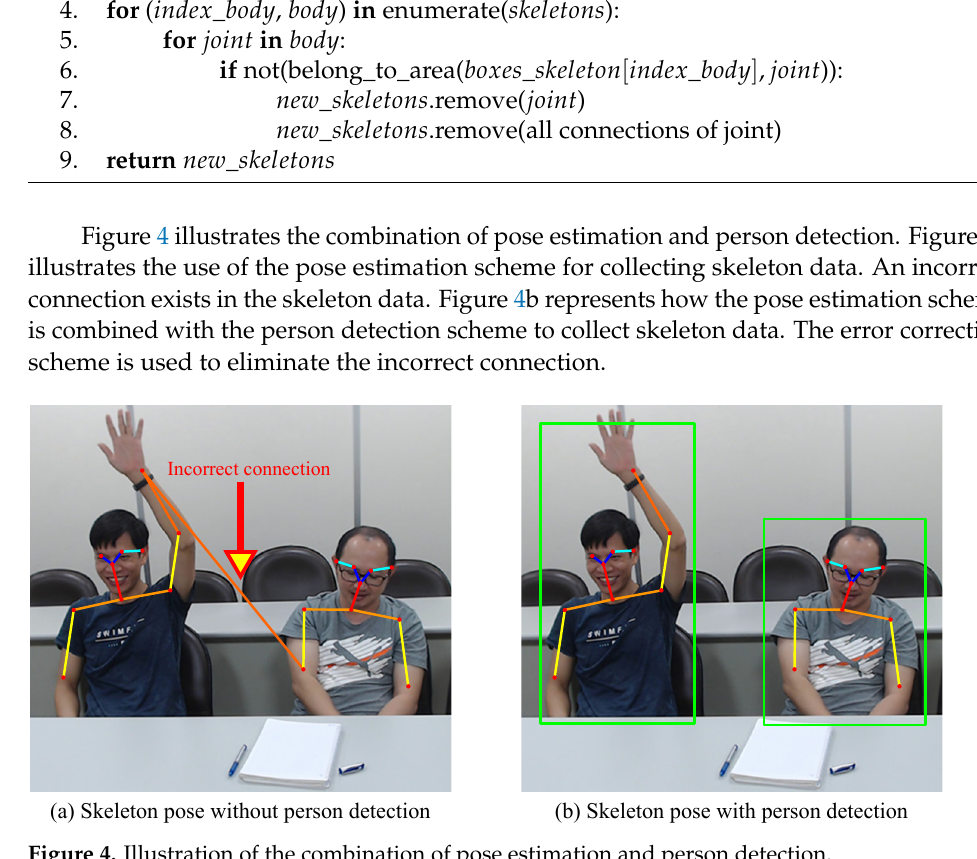
Figure 4. Illustration of the combination of pose estimation and person